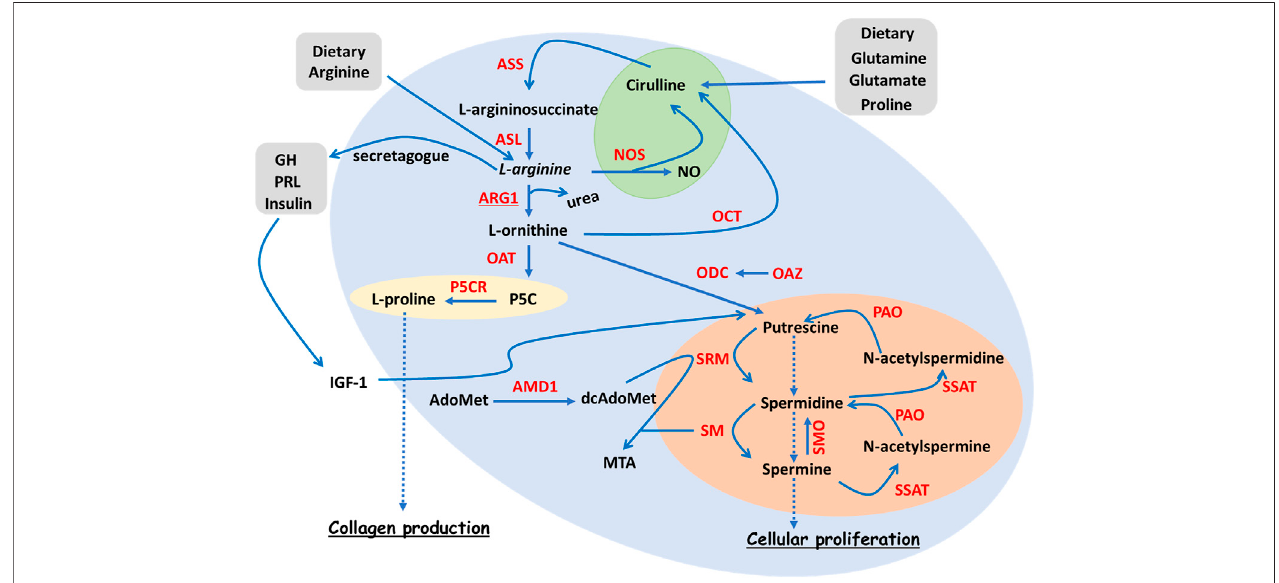
FIGURE 1 | Overview of L-arginine metabolism. Simpli fi ed diagram summarising the ARG pathways, together with polyamine and collagen synthesis. The NOS branchoftheARGpathwaysishighlightedingreen,polyamineproductioninorangeandcollagenproductioninyellow.L-arginineisanAAthatcanbederivedeitherfrom diet or from recycled L-citrulline deriving from glutamate, glutamine or proline. L-arginine can be metabolised by ARG1 during the urea cycle, L-ornithine and urea being its breakdown products. L-ornithine, in turn, can be the precursor of several molecular events including the synthesis of L-proline via OAT, the synthesis of the polyamine putrescine via ODC, and the production of L-citrulline via OCT. L-proline represents a key collagen building block. Putrescine, together with its downstream products spermidine and spermine, make up the reversible polyamine pathway that contributes to cell proliferation. An important rate-limiting enzyme of the polyamine pathway is AMD1. L-arginine is also a secretagogue for growth hormone (GH), which contributes to cell proliferation via IGF-1-dependent polyamine pathway enhancement.Finally, L-arginine canbe metabolised byNOS,thereaction productsbeing NOand L-citrulline.Enzymes arehighlightedinred.Abbreviations:AA,amino acid; AdoMet, S-Adenosyl methionine; AMD1, AdoMet decarboxylase; ASL, argininosuccinate lyase; ASS, argininosuccinate synthase; dcAdoMet, decarboxylated AdoMet; GH, growth hormone; IGF-1, insulin-like growth factor 1; MTA, 5 ′ -methylthioadenosine; NO, nitric oxide; NOS, nitric oxide synthase; OAT, ornithine aminotransferase; OAZ, ornithine decarboxylase antizyme; OCT, ornithine carbamoyl transferase; ODC, ornithine decarboxylase; P5C, L- Δ 1-pyrroline-5-carboxylate; P5CR, P5C reductase; PAO, polyamine oxidase; PRL, prolactin; SM, spermine synthase; SMO, spermine oxidase; SRM, spermidine synthase; SSAT, spermidine ⁄ spermine N1